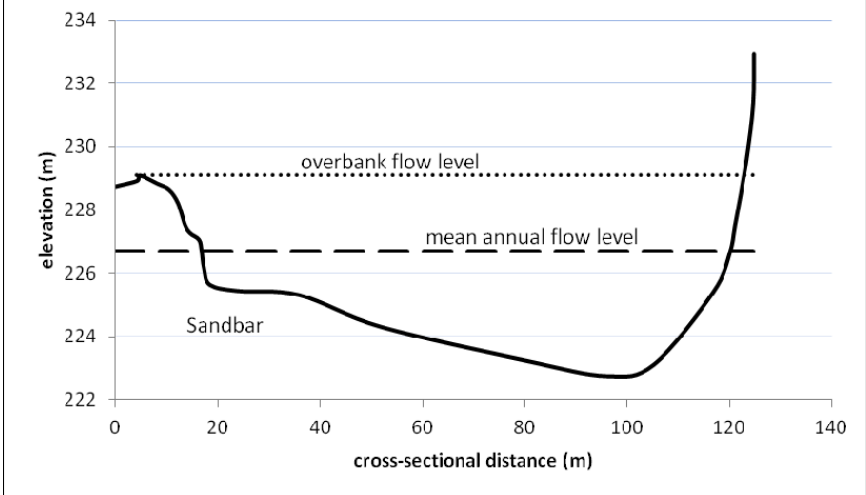
Figure 5. Cross-section of a sandbar on the Minnesota River from the turtle survey. Most of the sandbar surface area was below the mean annual flow level. No turtle nests were found in this location. The elevation of the sandbar may need to be built up higher through deposition to allow for nesting of smooth softshell turtles above the mean annual flow